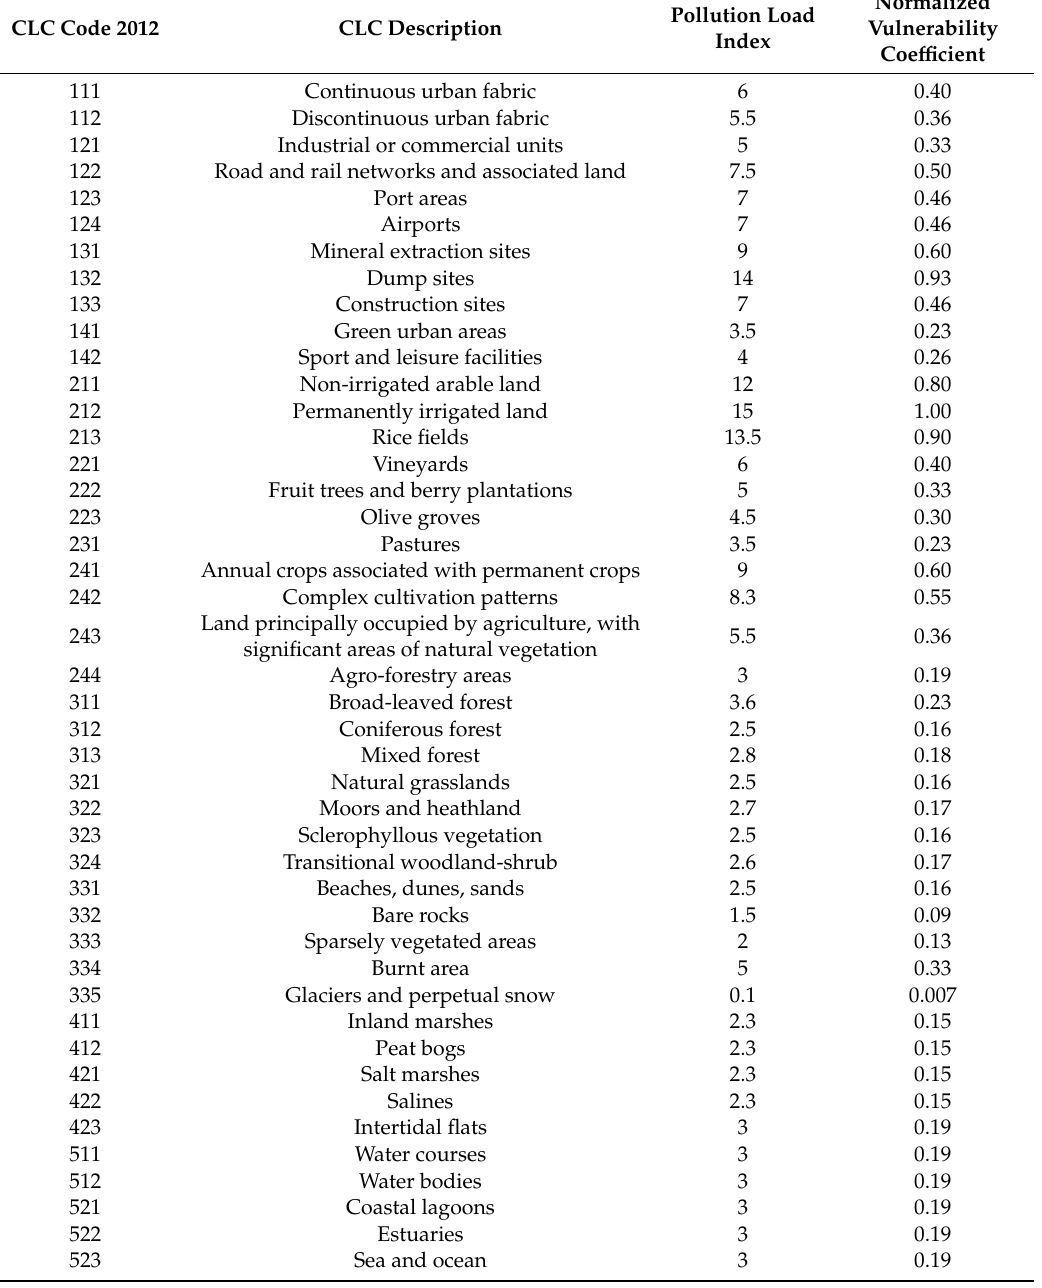
Table 3. Corine land cover classes and relative pollution load index applied for the 2012 in the Grand Est